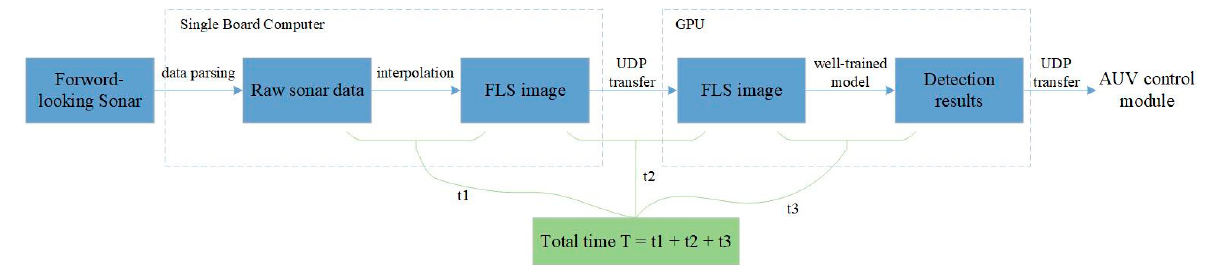
Figure 16. The process of the real-time detection experiment. Note: t1 is the time of interpolation, t2 is the time of transferring a FLS image, and t3 is the inference time of the network.